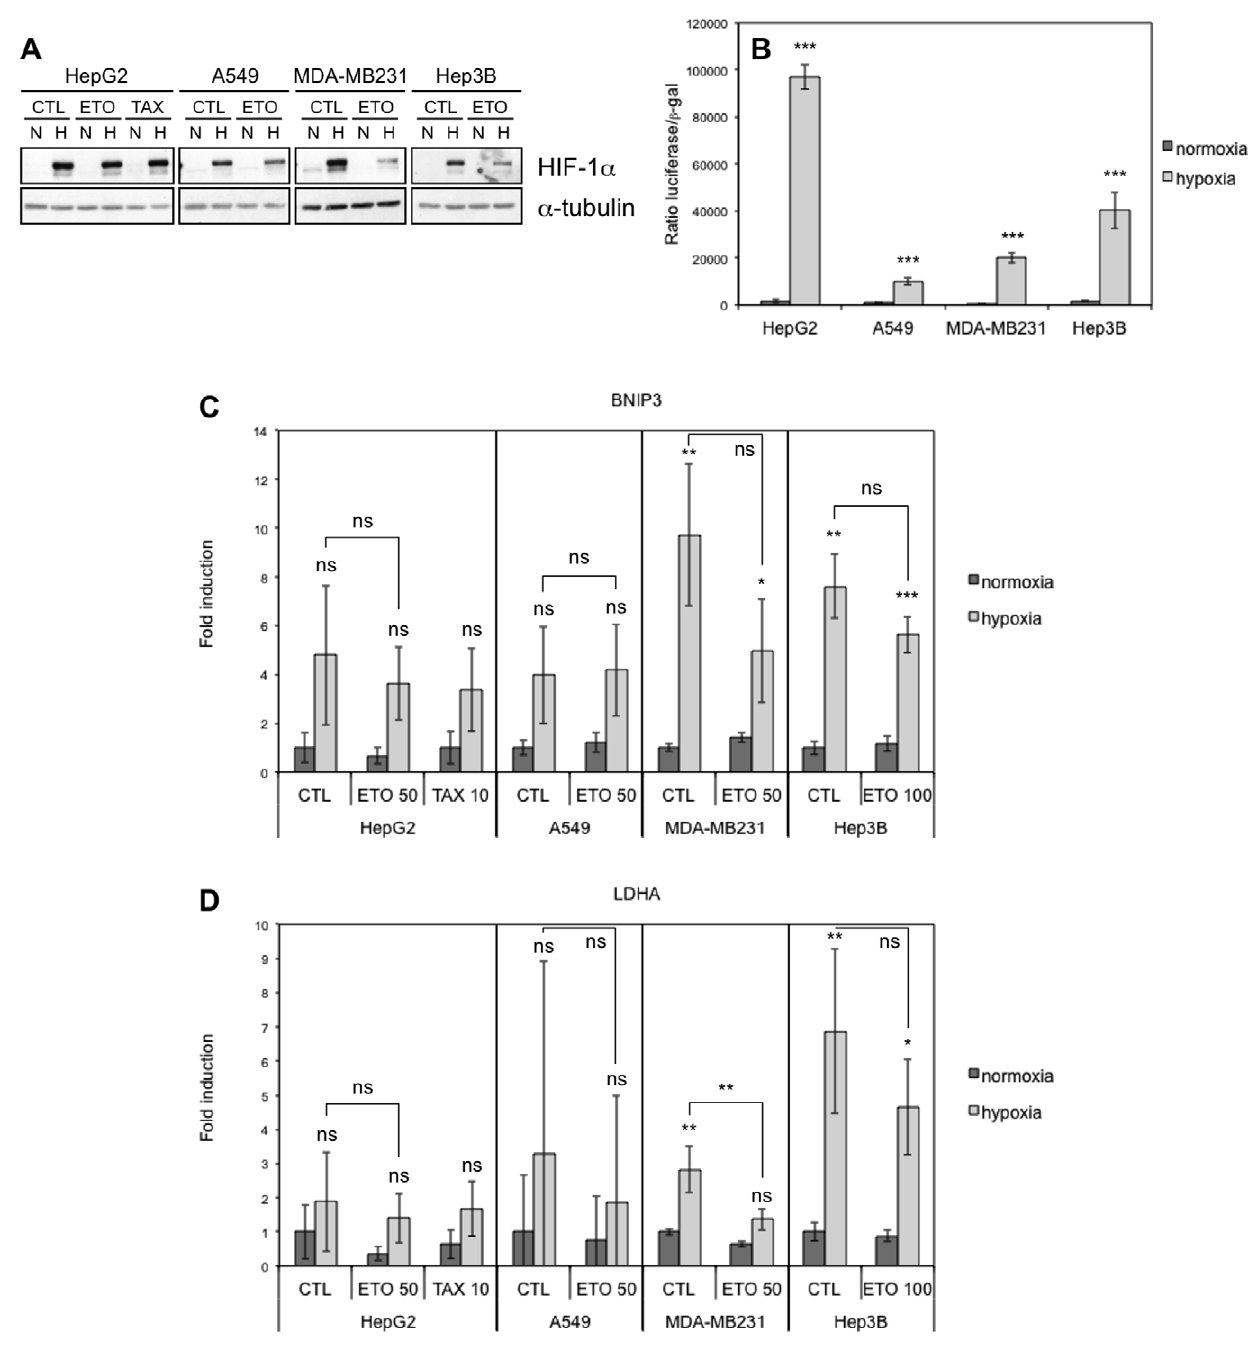
Figure 3. Effect of hypoxia, etoposide and paclitaxel on HIF-1alpha abundance and HIF-1 activity. HepG2, A549, MDA-MB231 and Hep3B cells were incubated 16 hours under normoxia (N, 21% O 2 ) or hypoxia (H, 1% O 2 ) (A-D) in the presence or not (CTL) of etoposide (ETO, 100 m M in Hep3B cells and 50 m M in the other cell types) or paclitaxel (TAX, 10 m M) in HepG2 cells (A, C, D). (A) HIF-1alpha was detected in total cell extracts by western blotting using a specific antibody. Alpha-tubulin was used as loading control. One experiment representative out of three. Uncropped western blots are presented in Figure S1. (B) Before incubation, cells were co-transfected with the pGL3-(PGK-HRE6)-tk-luc reporter plasmid encoding the firefly luciferase and the pCMVß normalisation plasmid. Results are expressed as mean of the ratio between firefly luciferase activity and ß- galactosidase activity 6 1 SD (n=3). Statistical analysis was carried out with ANOVA 1. ***: P , 0.001. Symbols are a comparison between the normoxic and hypoxic conditions of the same cell type. (C, D) After incubation, total RNA was extracted, submitted to reverse transcription and then to amplification in the presence of SYBR Green and specific primers for BNIP3 ( c ) or LDHA (D). RPL13A was used as housekeeping gene for data normalization. Data are given in fold-induction as the mean 6 1 SD (n =3). Statistical analysis was carried out with ANOVA 1. ns: non-significant; *: P , 0.05; **: P , 0.01; ***: P , 0.001. Symbols above the hypoxic columns are a comparison with the corresponding normoxic condition (with the same drug).